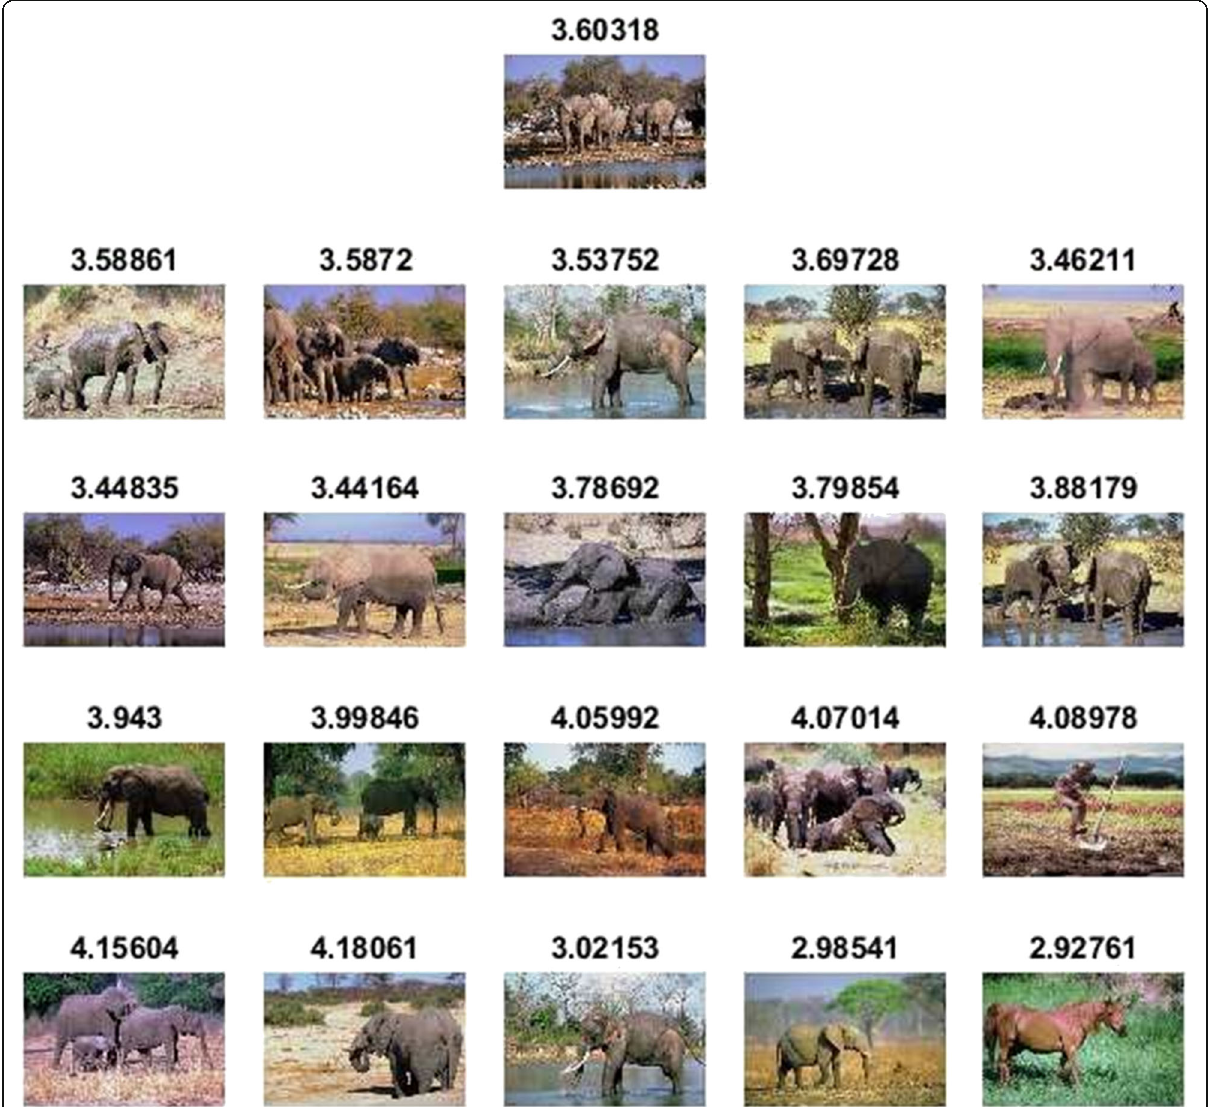
Fig. 9 Top-20 retrieved images associated with “ Elephants ” class of the image benchmark of the